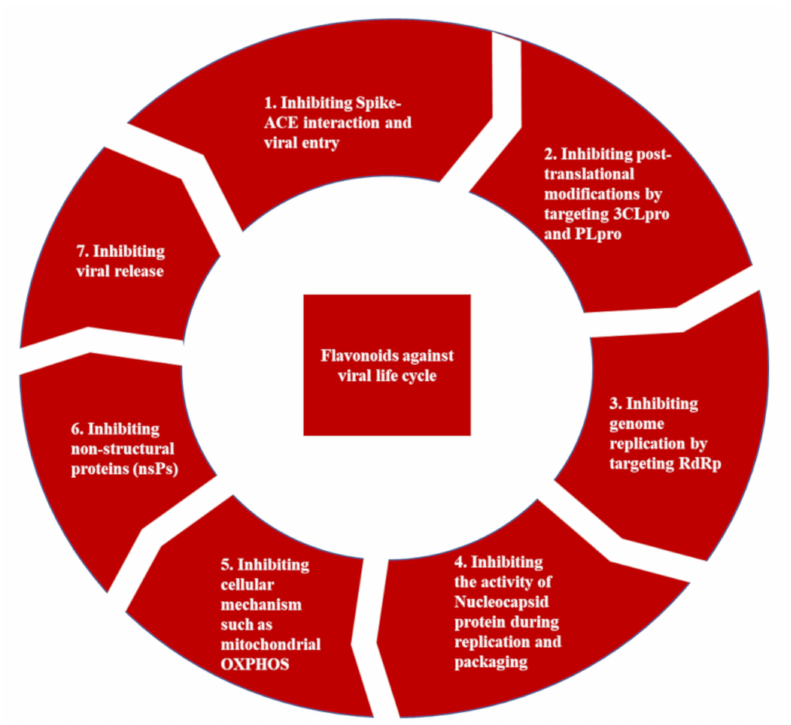
Figure 6. Viral and infected host cell targets important for potential therapeutics for inhibiting the viral pathogenesis of